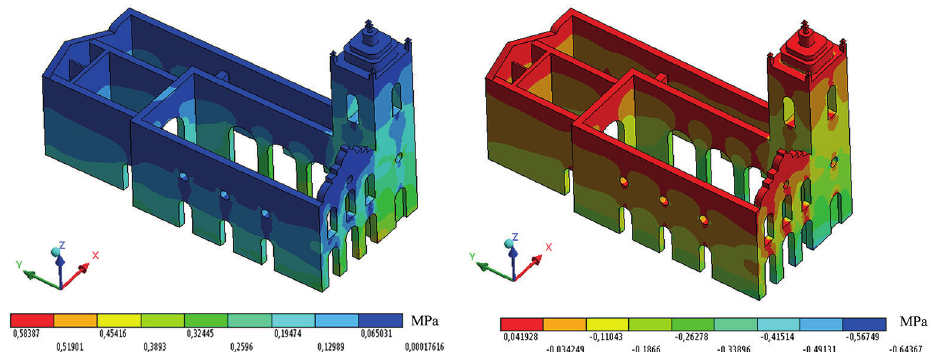
Fig. 15. Static analysis of the Nossa Senhora das Dores Church: Von-Mises stress (a) and normal stress in Z axes